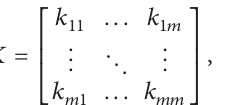
Figure 8: Entropy of the temperature distribution, where the red dash line is the ideal case and the blue one is the real